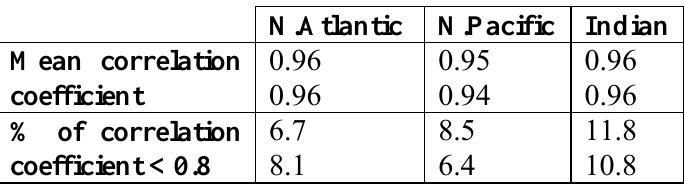
Table 3. Mean correlation coefficient between the SLP, and percentage of cases for which this correlation is lower than 0.8, for each ocean basin. The upper value is for the